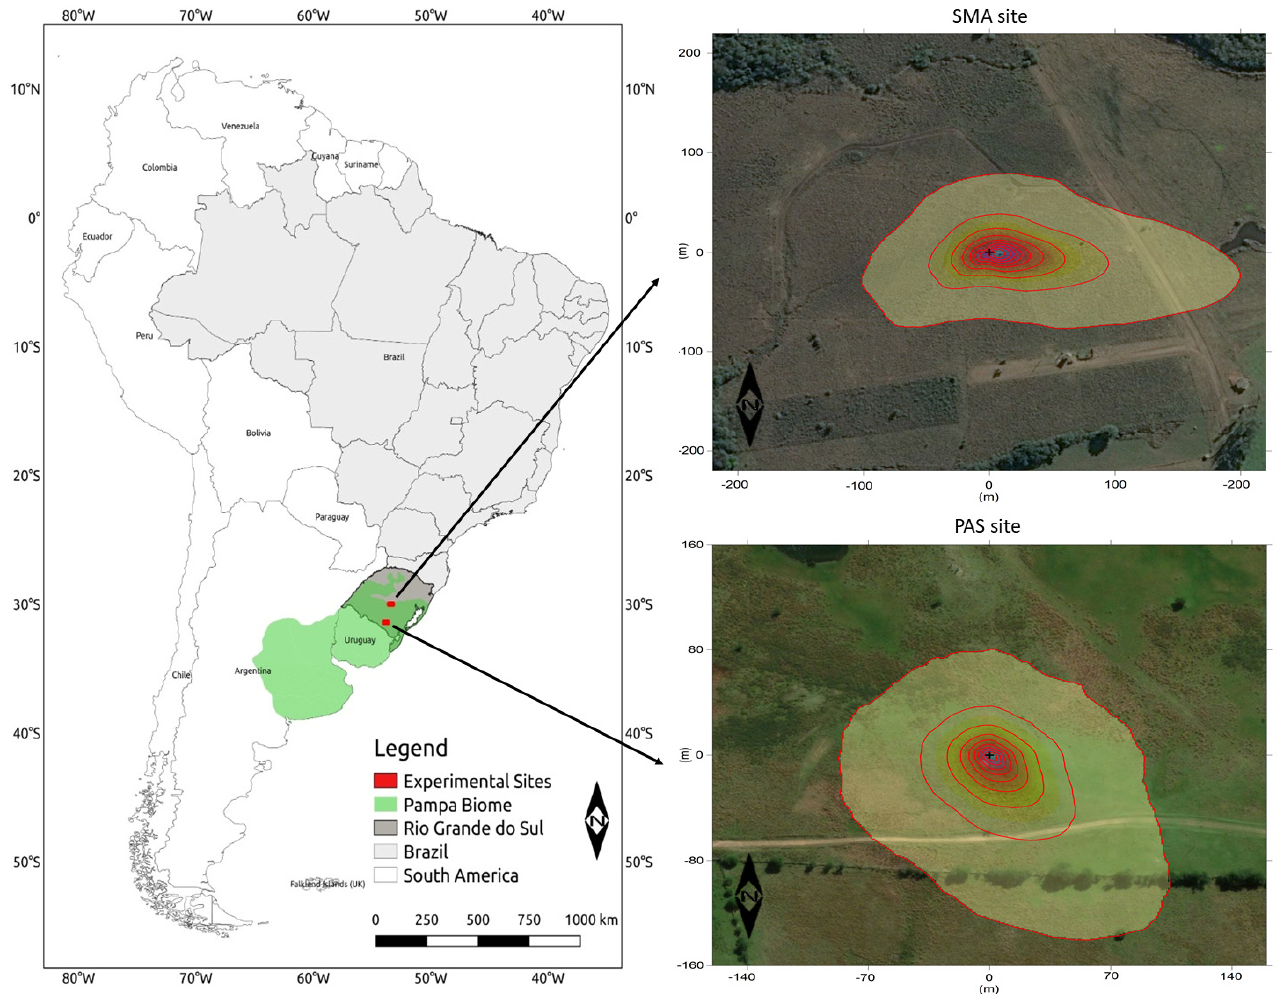
Figure 1. Location of the study areas in the Pampa biome—Santa Maria (SMA) and Pedras Altas (PAS). The footprint climatology (until 90%) of the flux measurements for both sites is presented in the right panel. The image of the area was not obtained in the period of the experiments analyzed in this study.